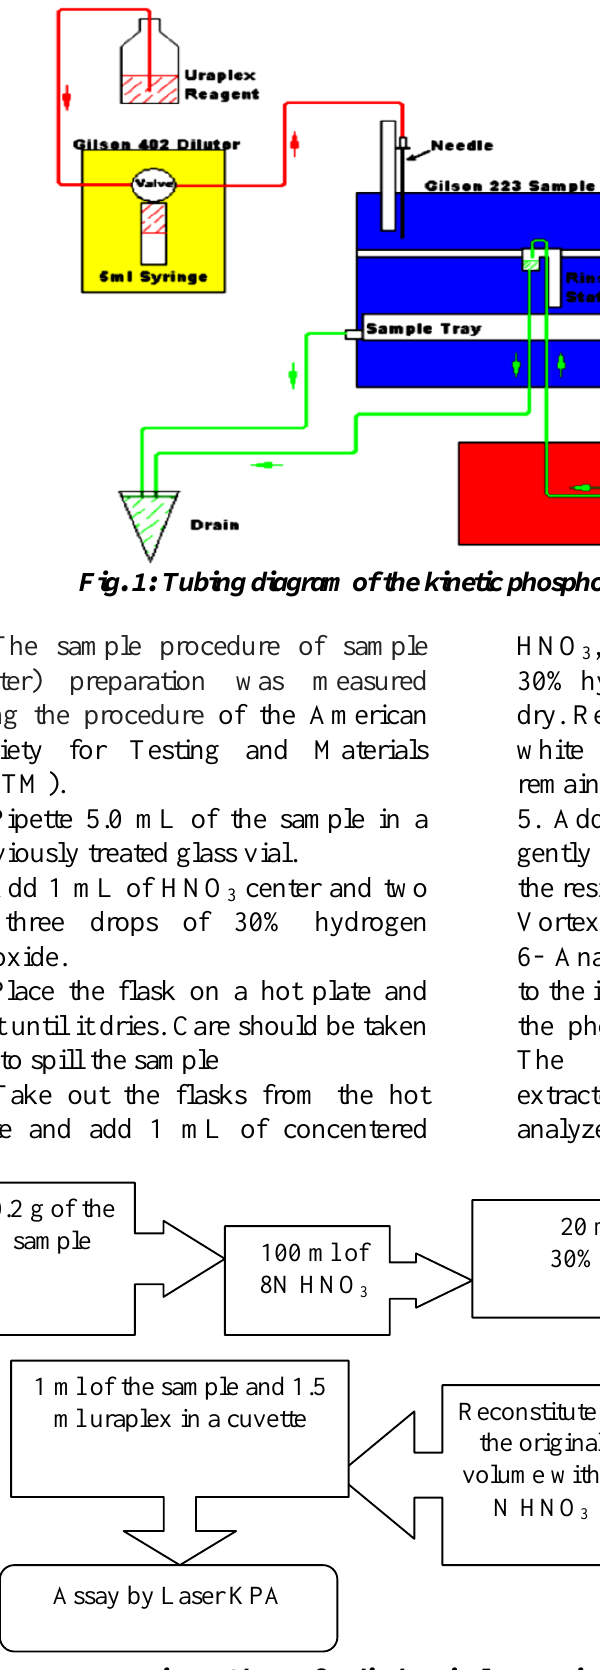
Fig. 2: Chart of radiochemical extraction of uranium [9].